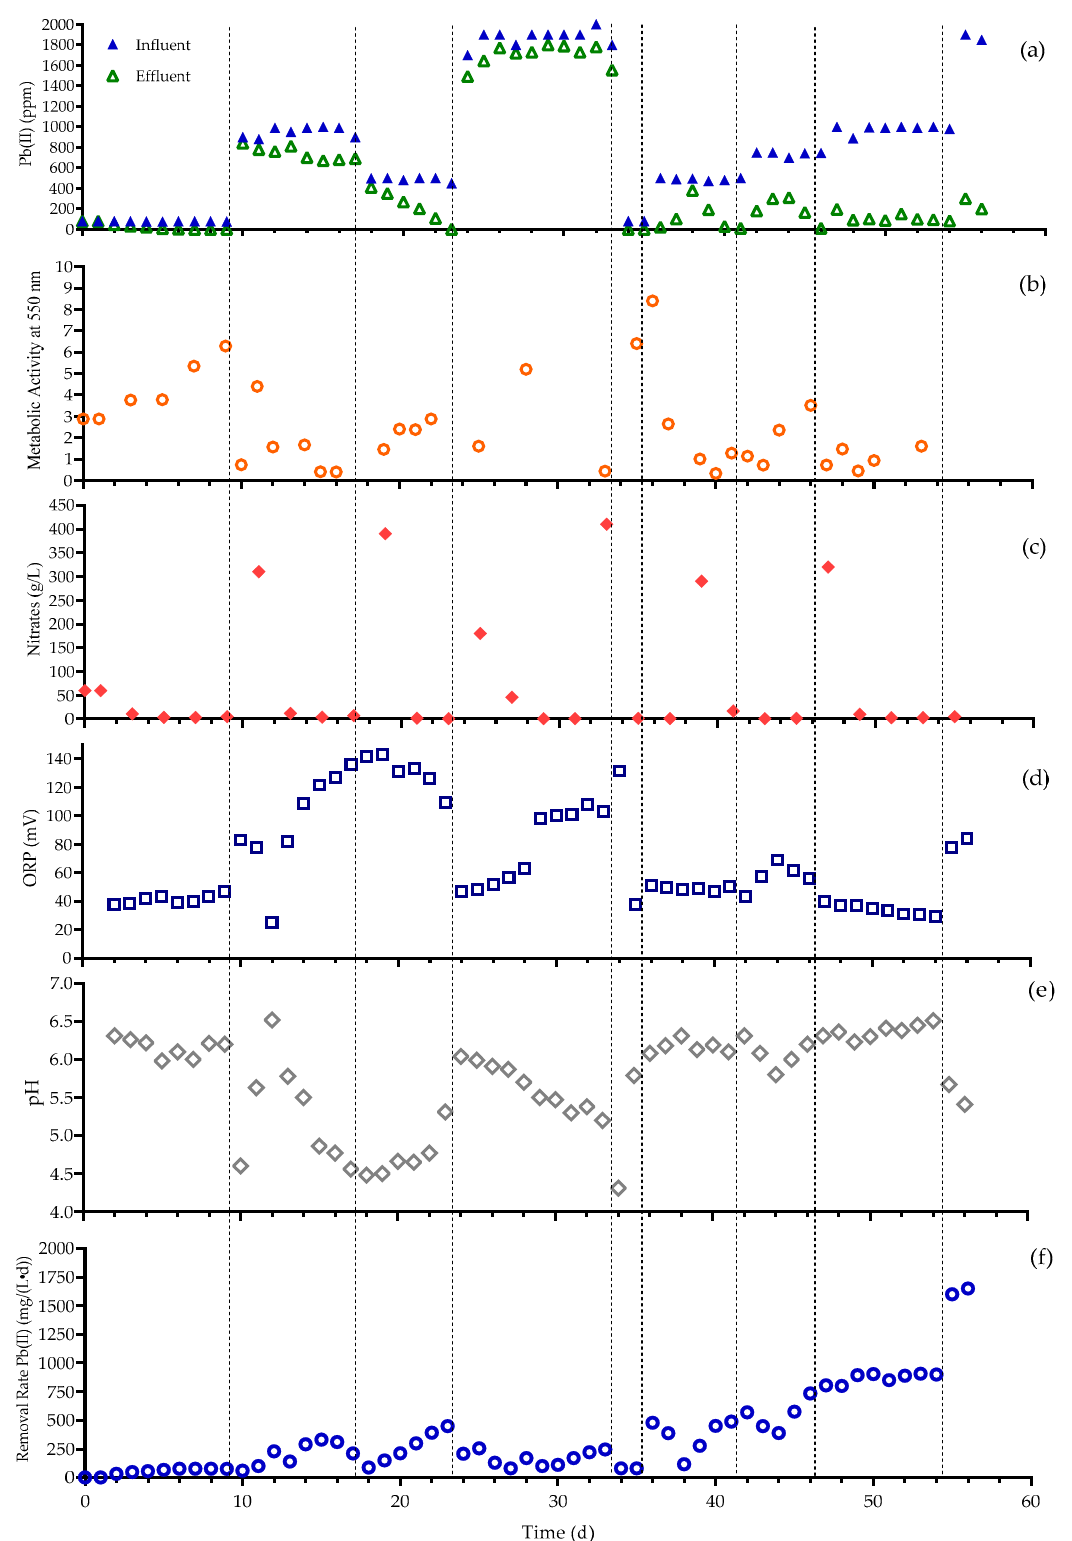
Figure 3. The lead level ( a ), metabolic activity ( b ), nitrate measurements ( c ), ORP ( d ), pH ( e ) and Pb(II) removal rate ( f ) over time for run 2.